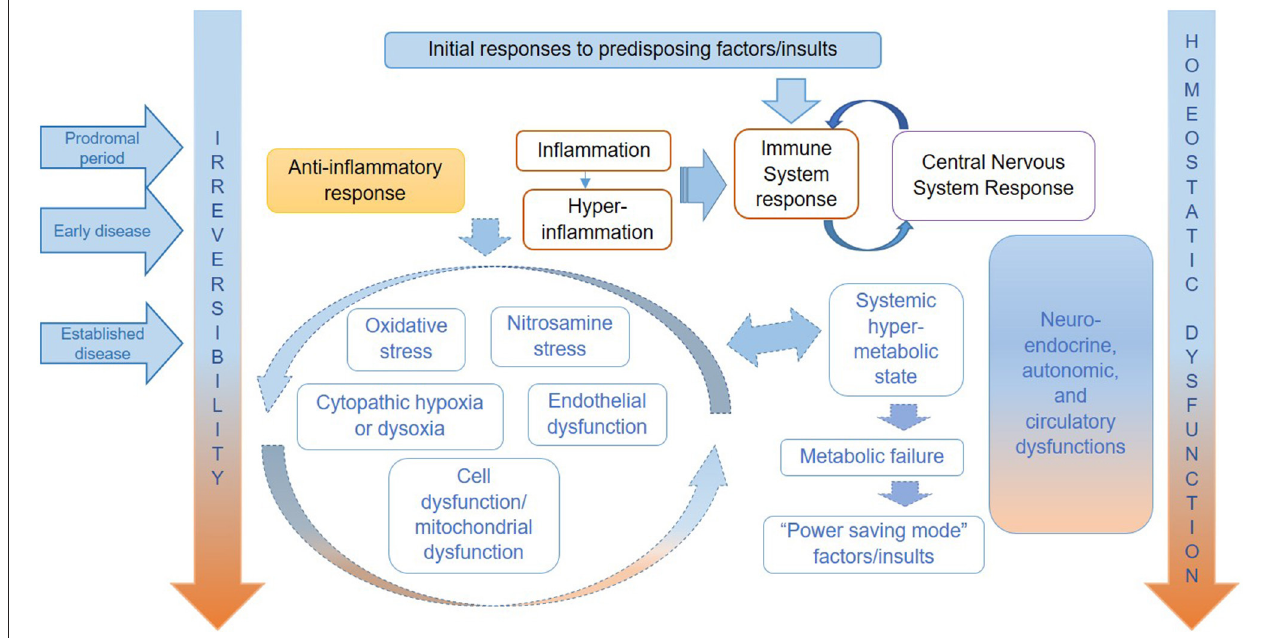
FIGURE 1 | Hypothesised key pathophysiological mechanisms for